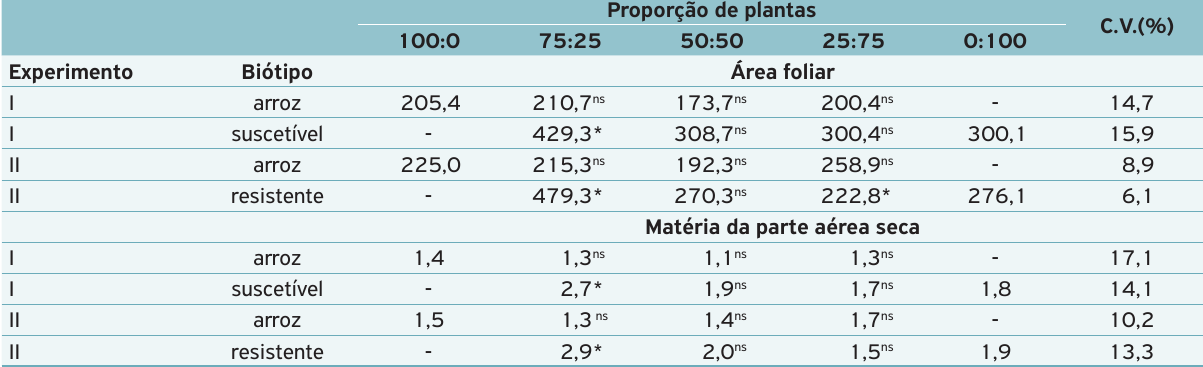
ns : não significativo; *significativo em relação à respectiva testemunha (100%) pelo teste de Dunnett (p ≤ 0,05).